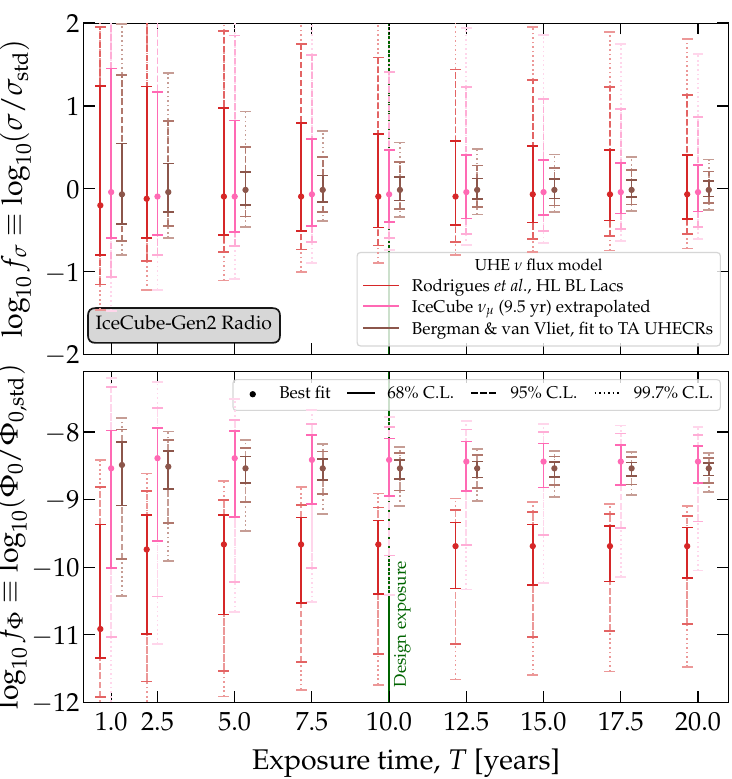
Figure 20 . Evolution with exposure time of the precision in the forecast measurement of the UHE νN cross section ( top ) and the UHE neutrino flux normalization ( bottom ) in the radio component of IceCube-Gen2, for benchmark flux models 2, 4, and 7; see figure 5. See the main text for